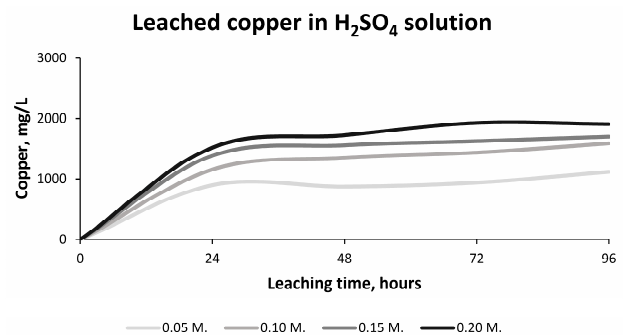
Figure 4. Comparison of the Copper concentrations in the four Sulphuric Acid solutions with different leaching times and leaching process at ambient temperature and atmospheric pressure.